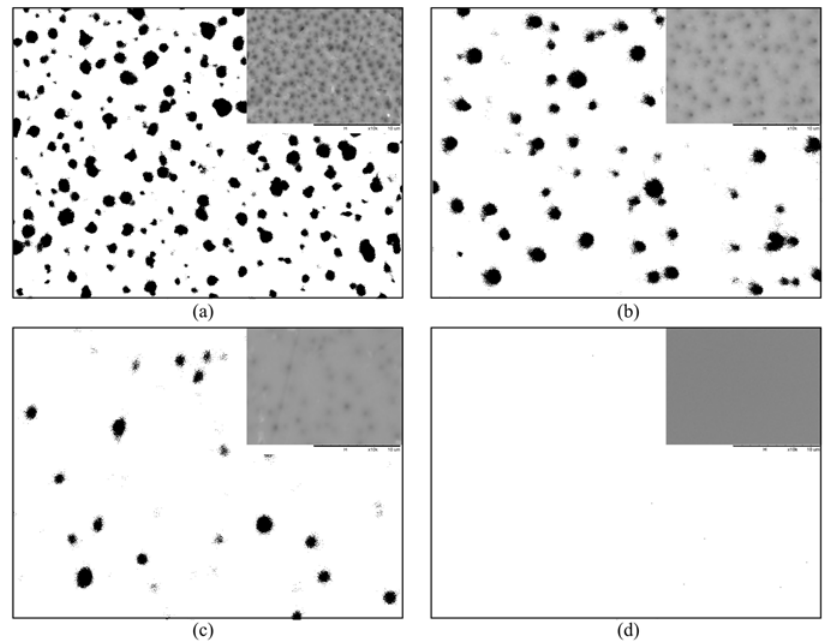
Figure 6. Surface morphology of substrate at ( a ) 21 wt% ( b ) 25 wt% ( c ) 27 wt% and ( d ) 29 wt% PES. Figure 7a provides performance data on the PES substrate at various concentrations.